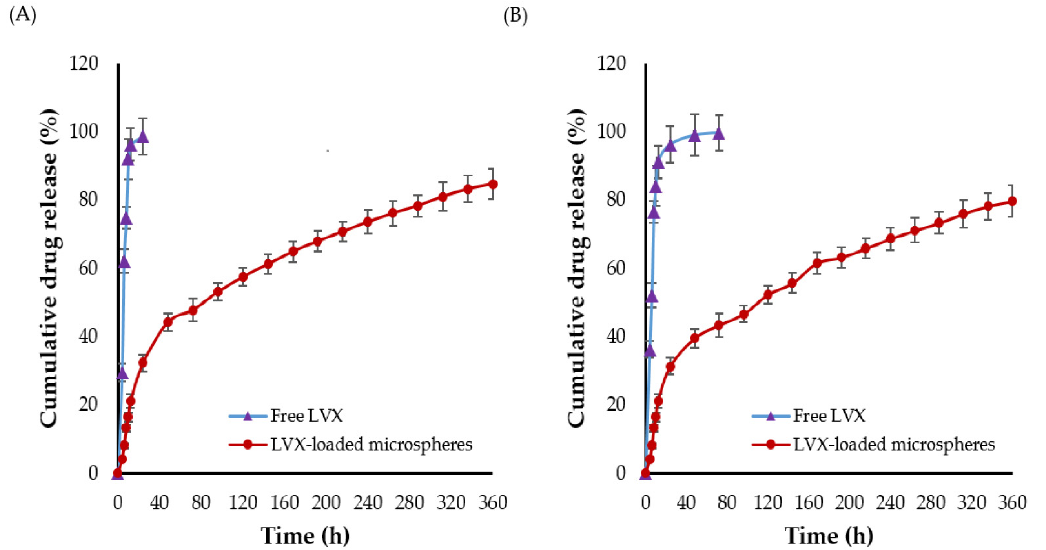
Figure 4. In vitro release of free LVX and LVX-loaded microspheres in ( A ) Acetate buffer (pH 4.4) and ( B ) Phosphate buffer (pH 7.4).